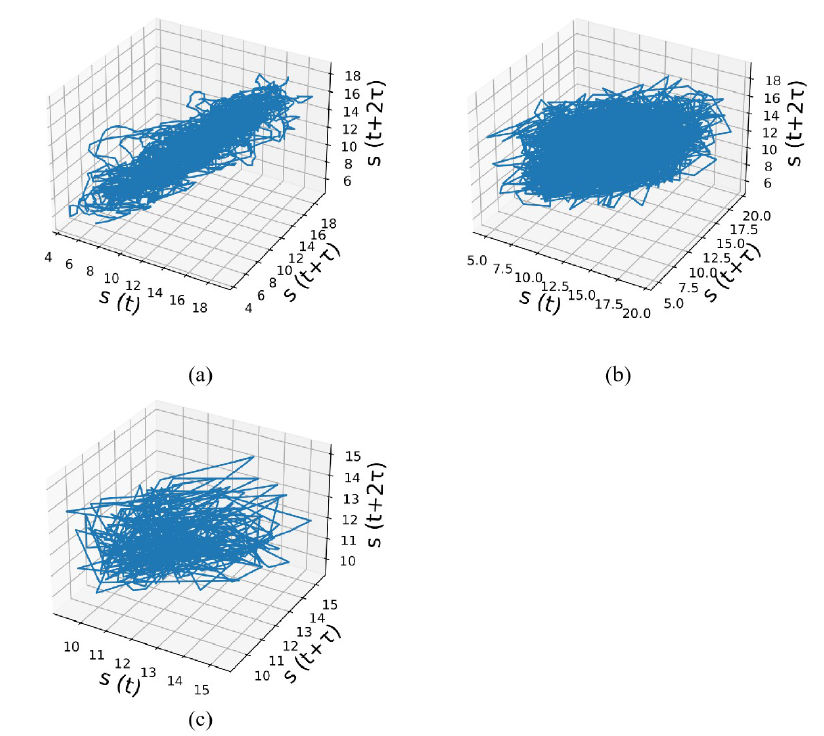
Figure 5. The three-dimensional phase space of the reconstructed EDH time series at three different timescales: ( a ) hourly, ( b ) daily, and ( c )